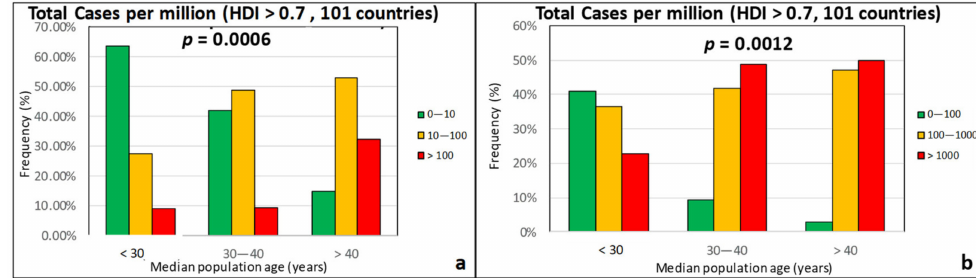
Figure 10. Frequency of ( a ) total deaths per million (green: low, 0–10; orange: moderate, 10–100; red: high, > 100) and ( b ) total cases per million (green: low, 0–100; orange: moderate, 100–1000; red: high, > 1000) as a function of the median age for countries with an HDI over